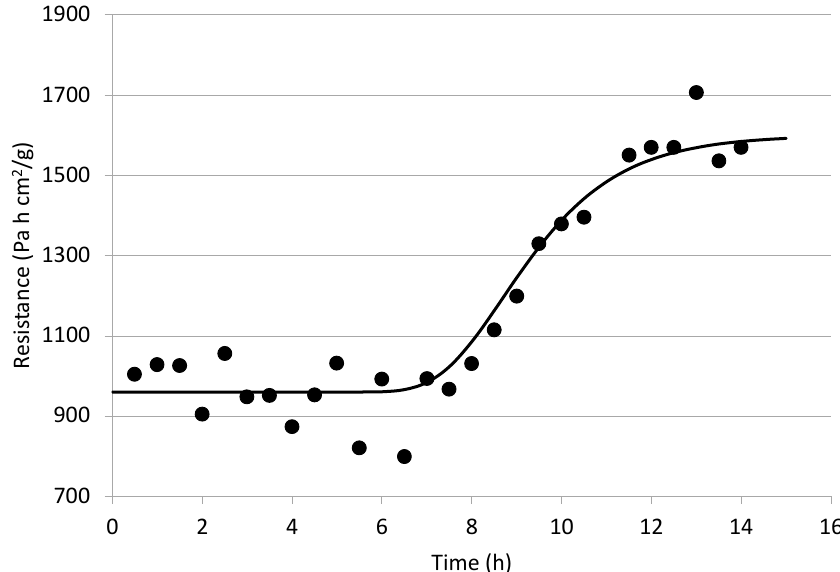
Figure 14. Values of (R T ) along the freeze-drying time ( • ) and its corresponding tendency line ( — ) of nine CO 2 laser microperforations treated blueberries.